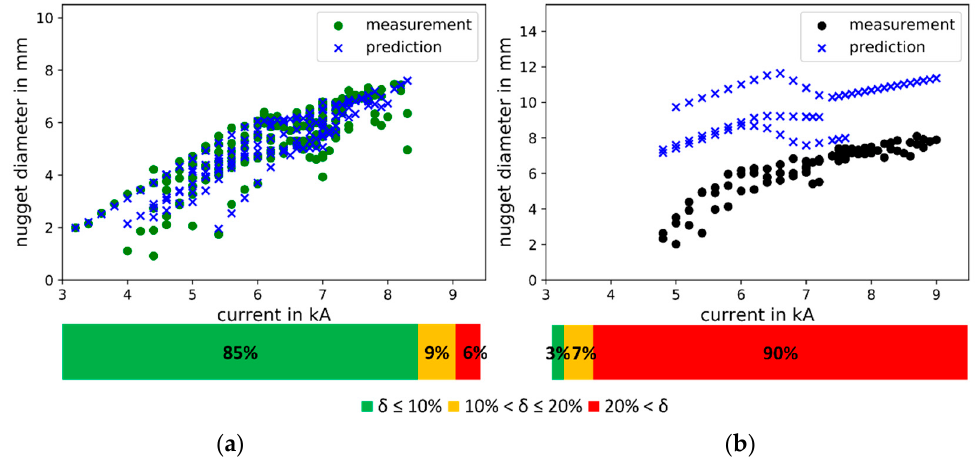
Figure 5. Predictive performance of the first model. Only process parameters were used as in- put for training: ( a ) scatter plot of the measured and predicted nugget diameters from dataset 1; ( b ) scatter plot of the measured and predicted nugget diameters from dataset 2. The bar charts show the predictive accuracy based on the prescribed